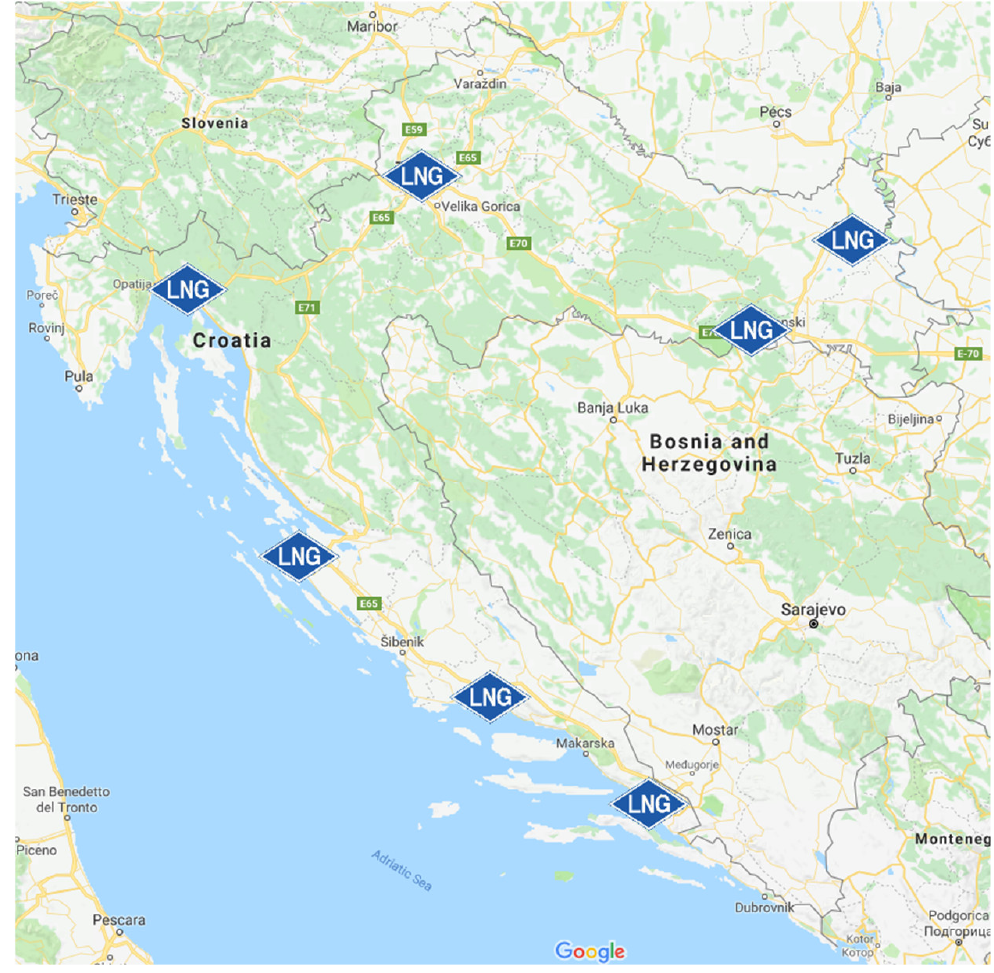
Figure 4. Infrastructure for the supply of LNG for heavy trucks from the National Policy Framework [6].